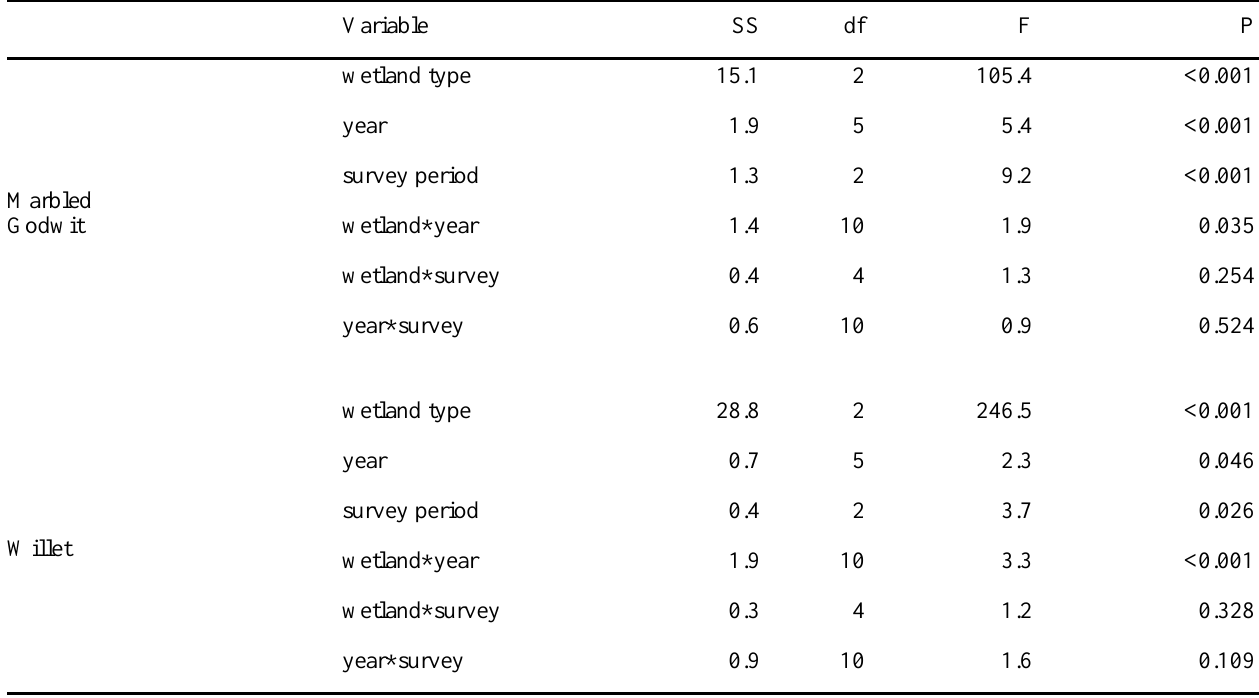
Table 2. Results of a 3-way ANOVA, type III SS, for marbled godwits and willets, based on log-transformed shorebird numbers. For both species, Dunnett C post hoc tests comparing wetland type were all significant ( P <